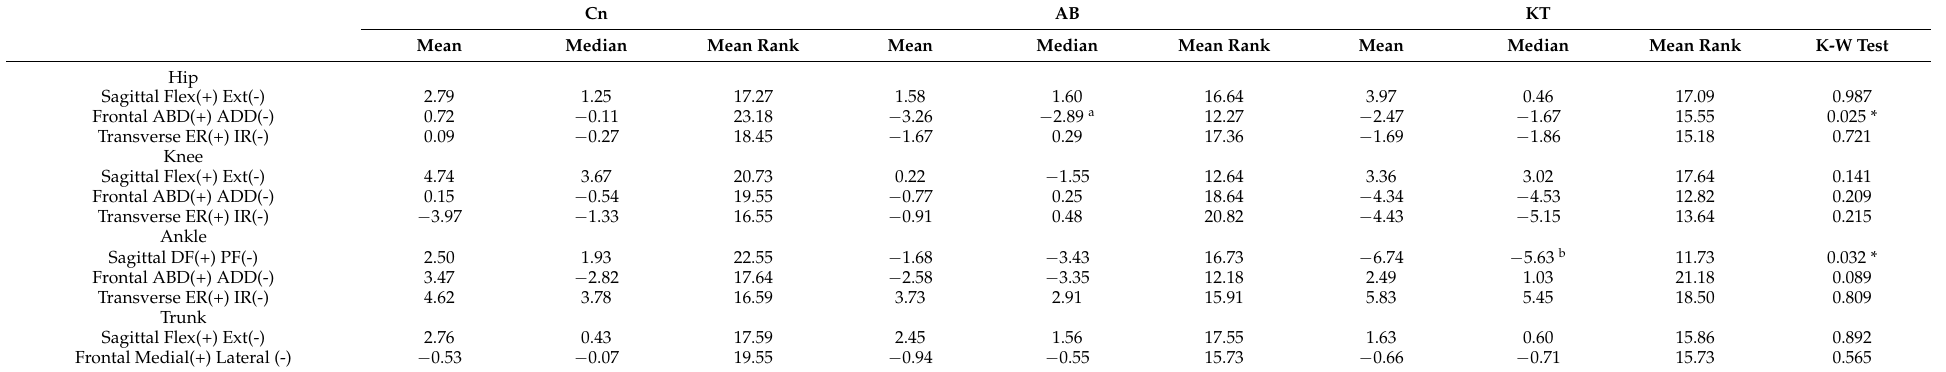
Table 1. Kruskal–Wallis and post hoc test results for fatigue-induced changes in the maximal joint angle in lateral drop landing tasks for the three groups. Cn AB KT Mean Median Mean Rank K-W Test